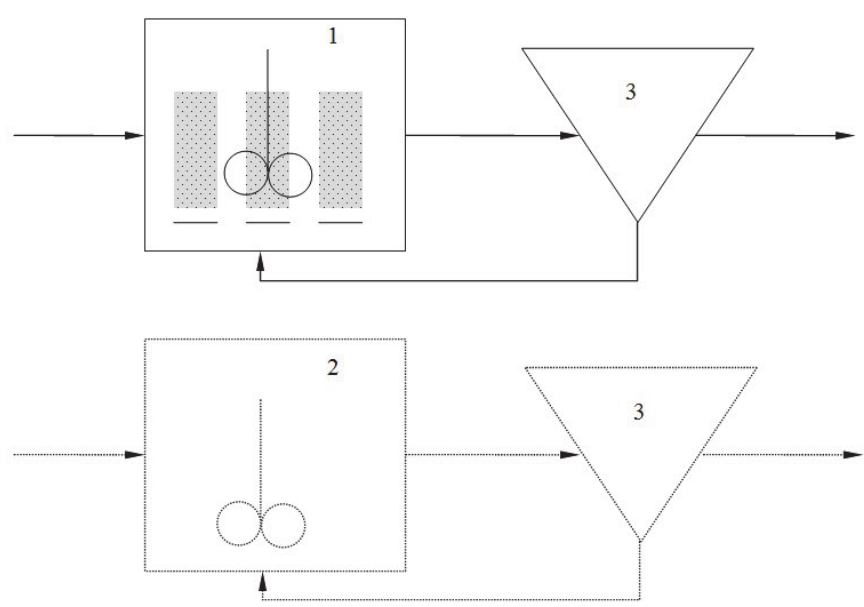
Fig. 1 – Scheme of an intermittently aerated completely mixed bioreactor IACMB; Fig. 1 1 – aerobic conditions, 2 – anoxic conditions, 3 – sedimentation tank